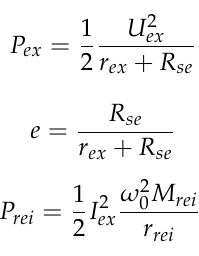
se , P ex , e and P rei